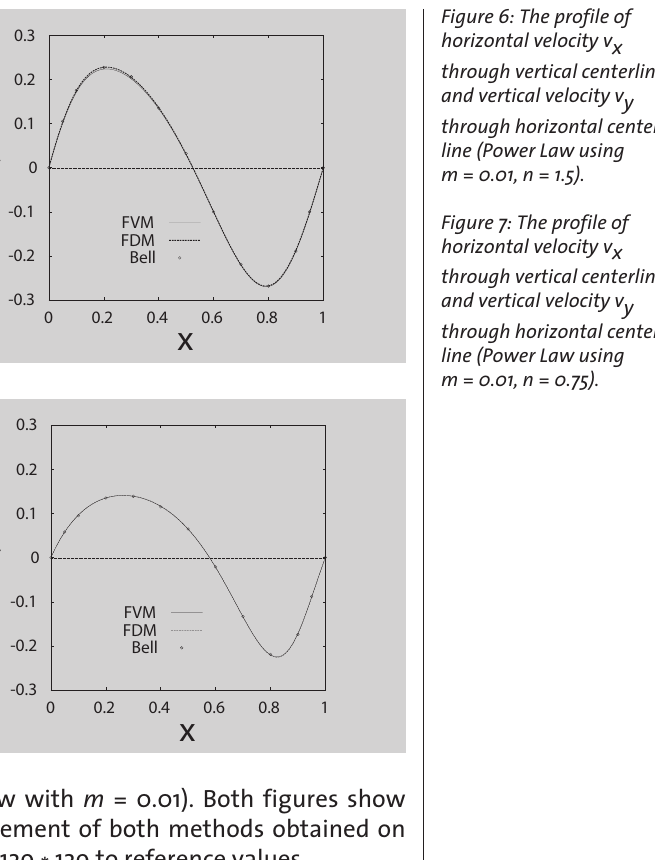
Figure 6: The profile of horizontal velocity vx through vertical centerline and vertical velocity vy through horizontal center- line (Power Law using m = 0.01, n = 1.5). Figure 7: The profile of horizontal velocity vx through vertical centerline and vertical velocity vy through horizontal center- line (Power Law using m = 0.01, n = 0.75).